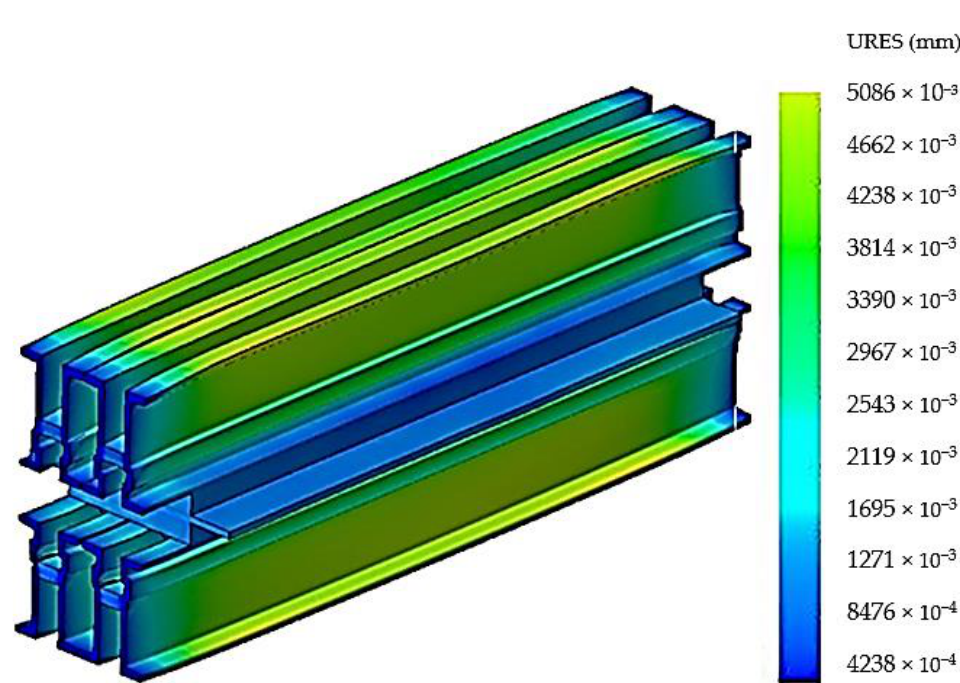
Figure 16. Deformation distribution in the belt vulcanization press with stiffening plate.